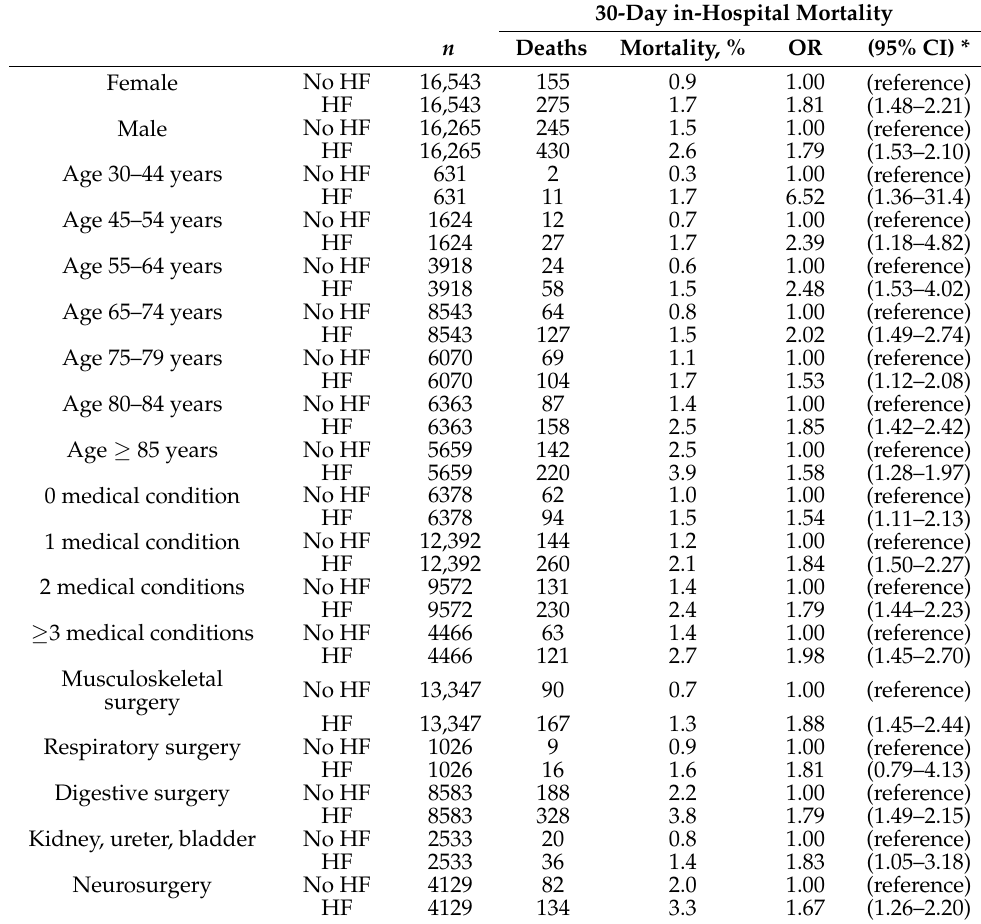
Table 3. The stratified analysis for mortality after noncardiac surgery associated with heart